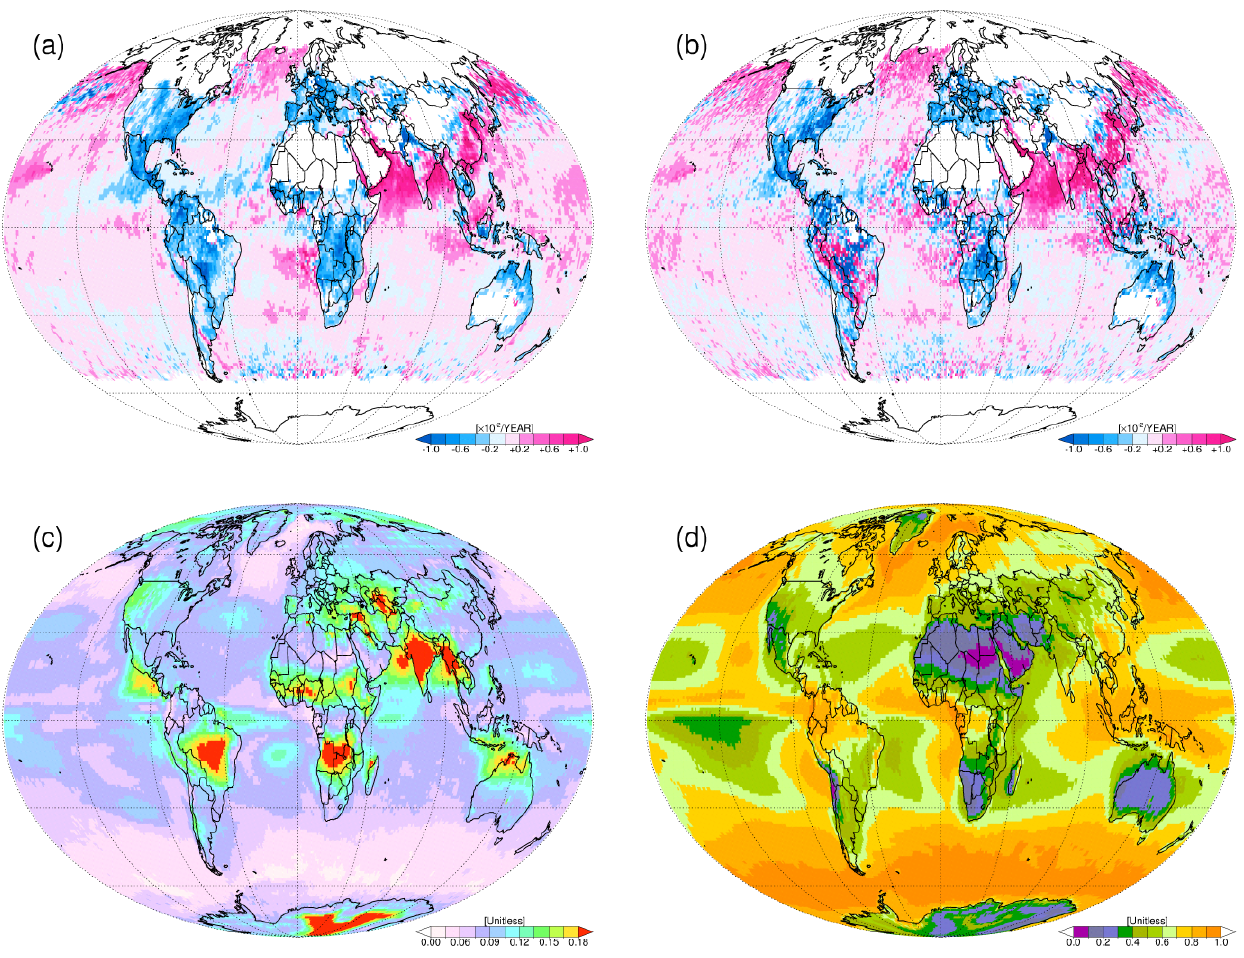
Figure 6. (a) Simple linear and (b) weighted trends of AOT (550nm) from MODIS (Terra) observations from March 2001 to December 2009. The standard deviation and mean of total cloud fractions in daytime for the same periods are shown in (c) and (d)